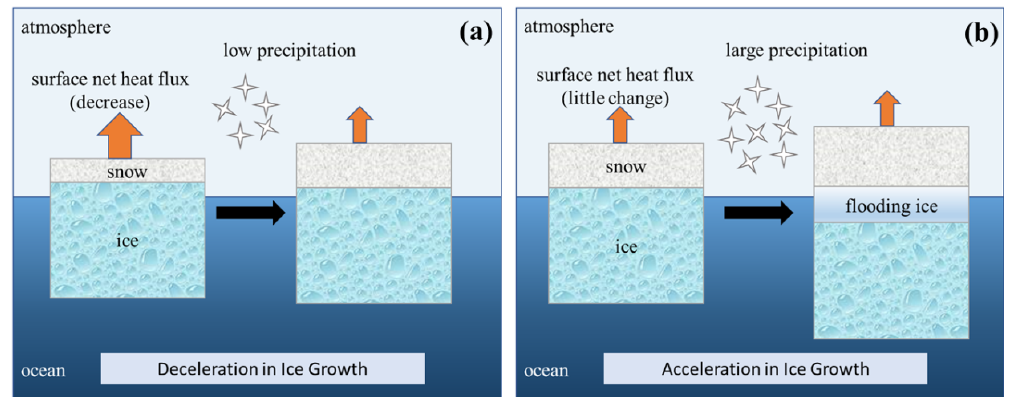
Figure 7. Schematic diagram for (a) low precipitation and (b) large precipitation events illustrating the precipitation effect on sea ice growth. The orange arrows represent surface net heat flux, and different colored boxes indicate the layer of snow, flood ice, and sea ice.